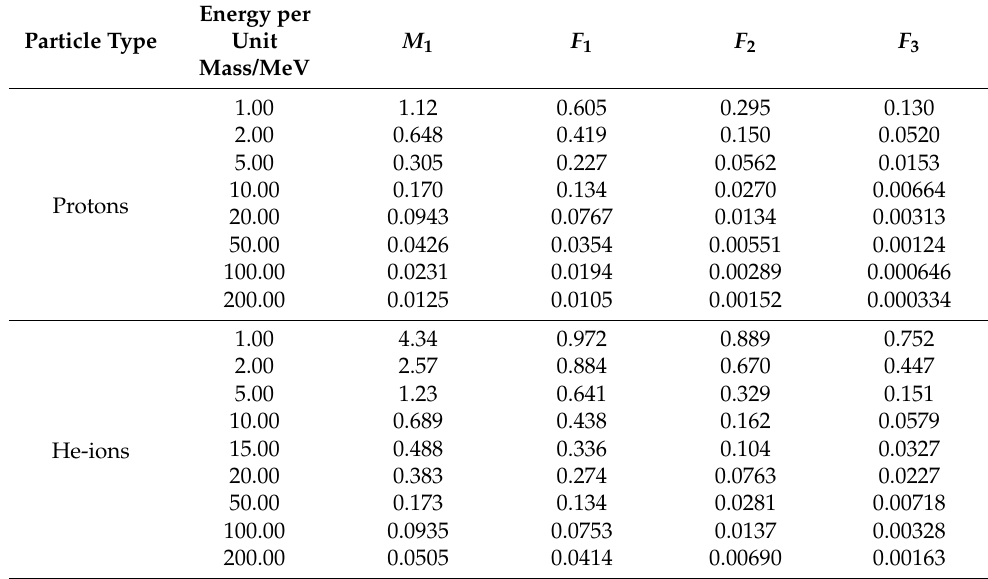
Table A2. Nanodosimetric quantities for protons, helium and carbon ions in a sphere of D = 2